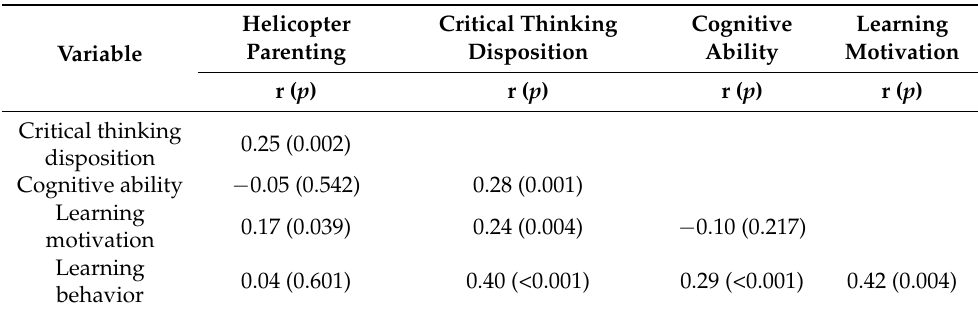
Table 3. Correlation of helicopter parenting, critical thinking disposition, cognitive ability, learning motivation, and learning behavior ( n = 149).